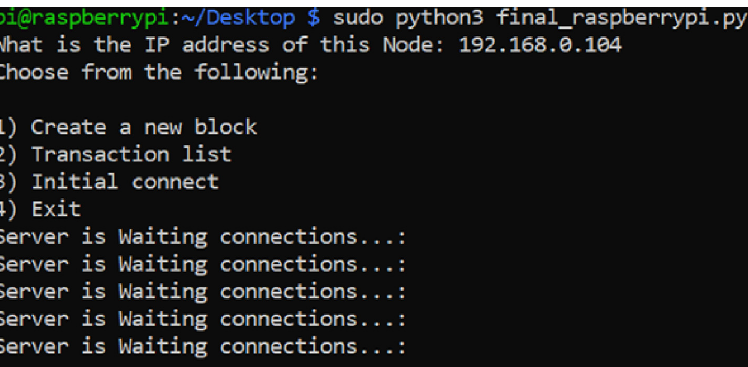
Figure 18. Starting the application.